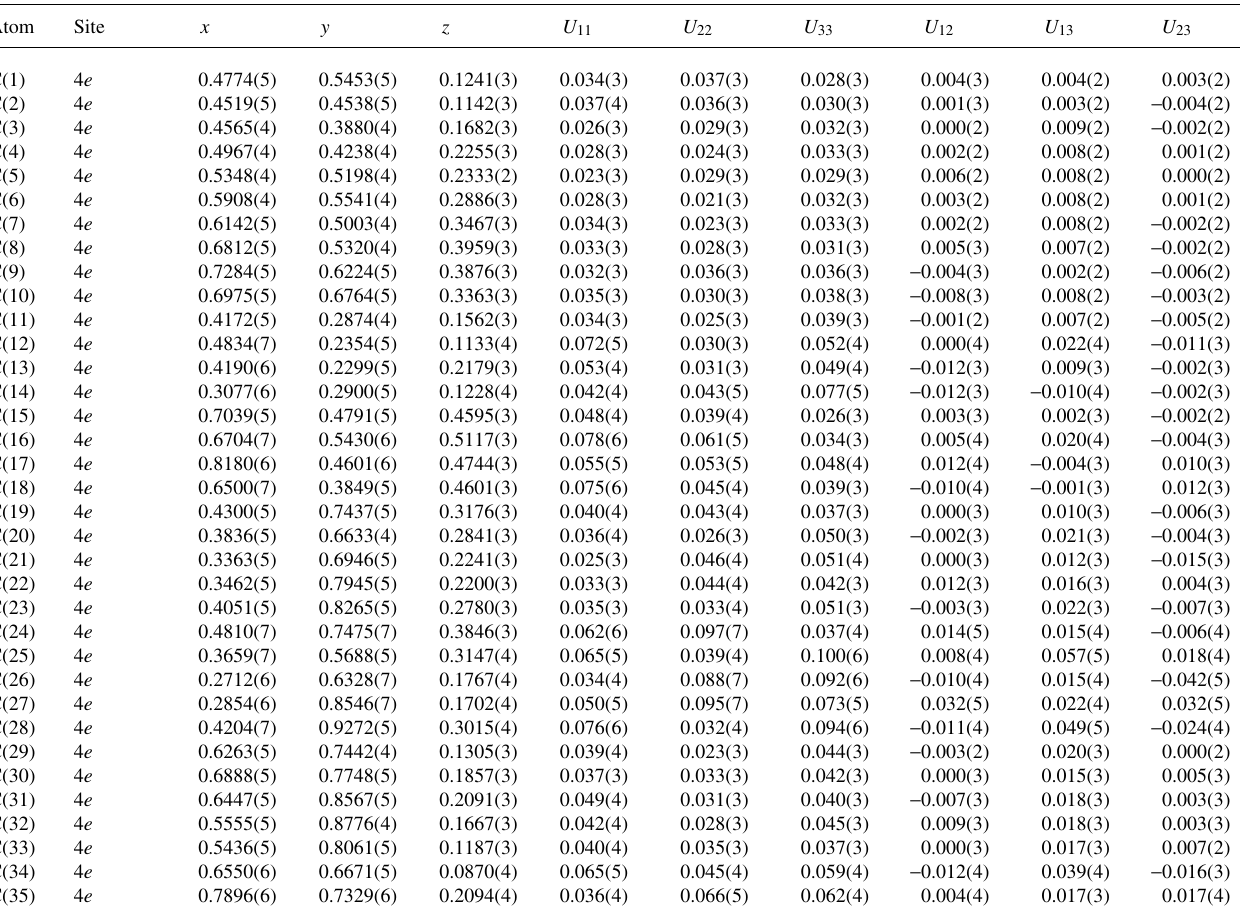
Table 3. Atomic coordinates and displacement parameters (in Å 2 )